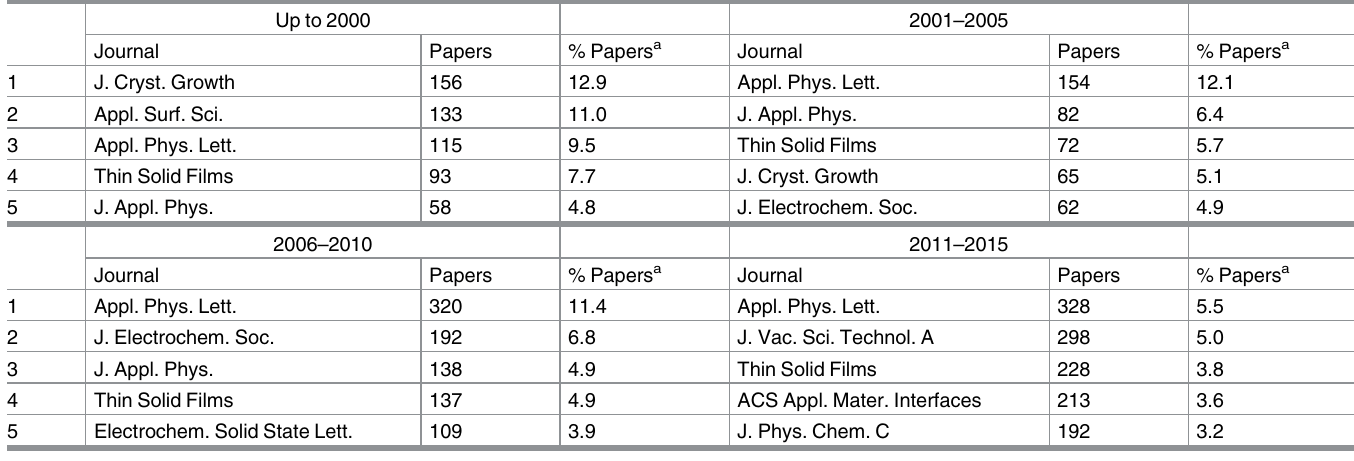
Table 2. Top 5 journals by the number of ALD papers published in different time periods. Up to